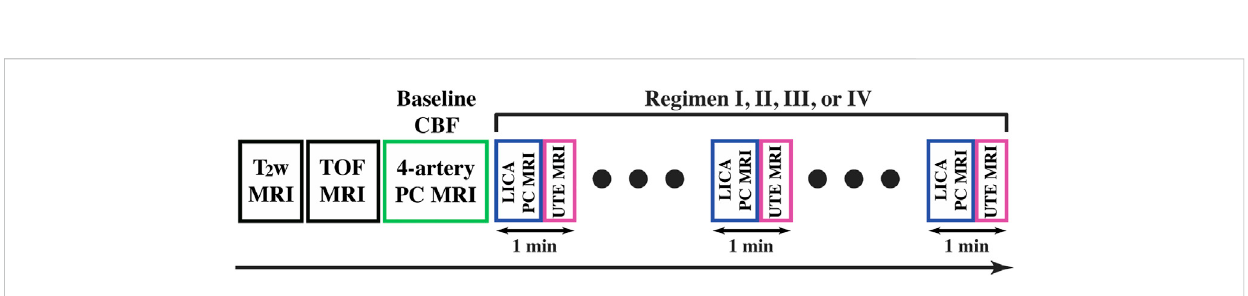
Schematic diagram of the experiments under different anesthetic regimens (I, II, III, and IV). T 2 -weighted (T 2 w) MRI was performed for evaluating brain volume and time-of- fl ight (TOF) MRI was performed for visualizing arteries. Baseline CBF was measured with 4-artery PC MRI prior to the planned anesthetic regimens. LICA PC and UTE sequences were utilized in an interleaved manner with a temporal resolution of 1